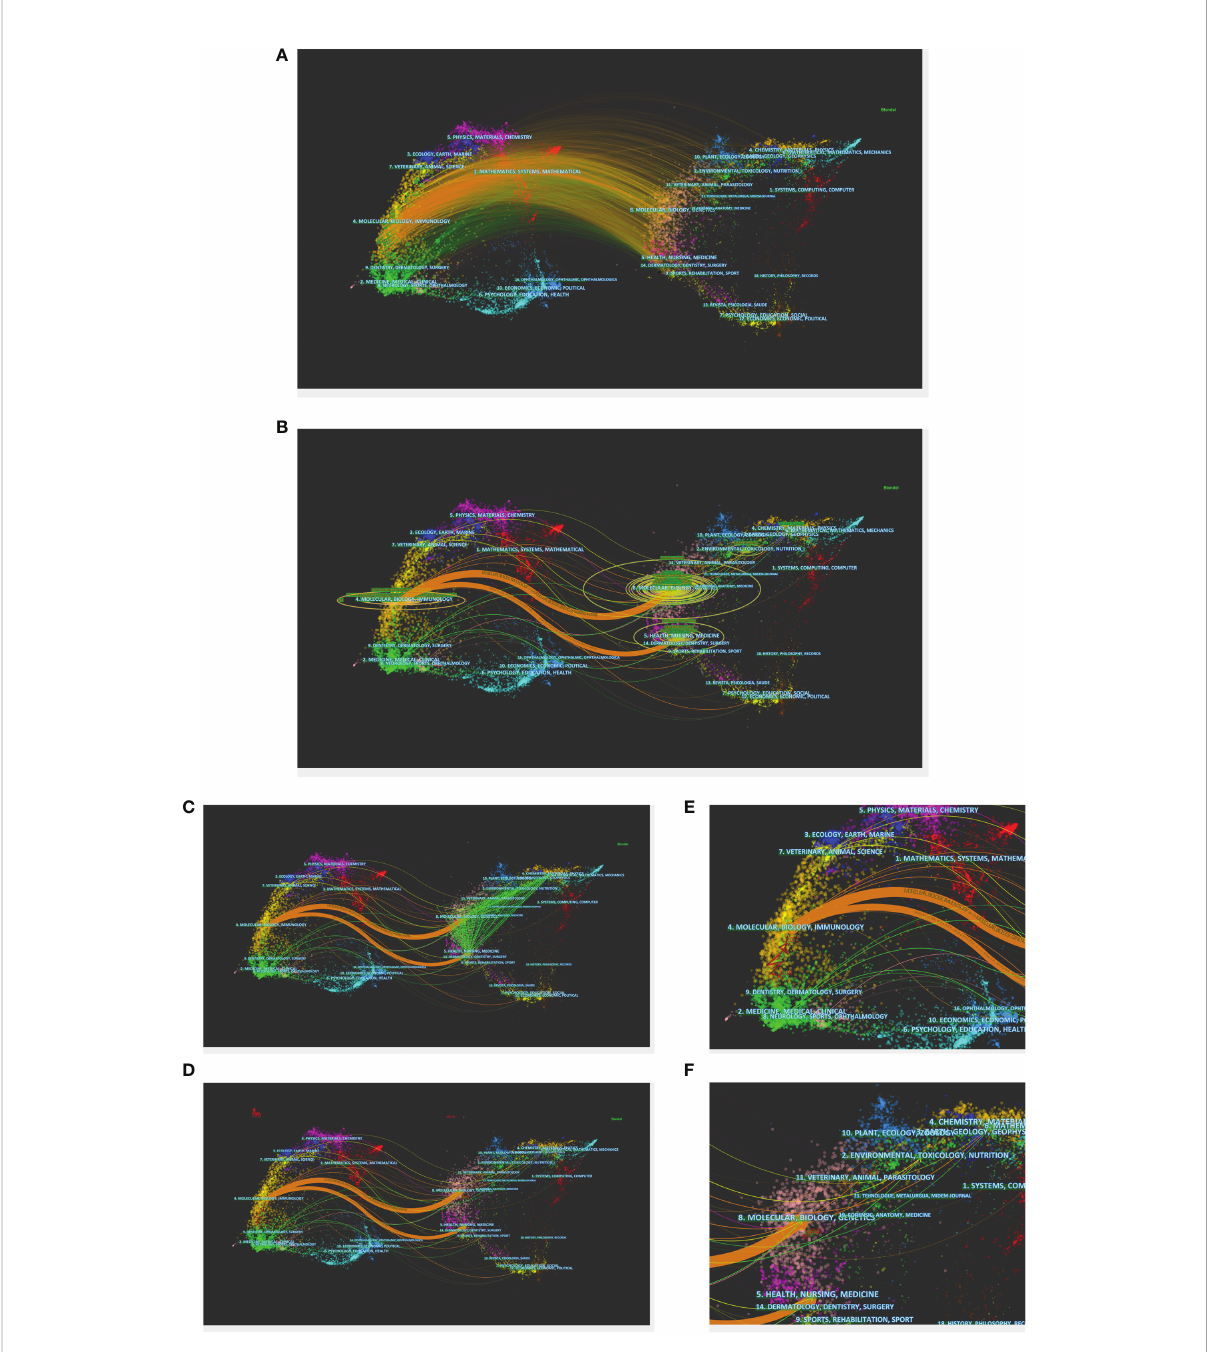
FIGURE 5 The dual-map overlay and corresponding disciplines. (A) The dual-map overlay of citing and cited article. Labels indicate corresponding disciplines of citing or cited articles. (B) The dual-map overlay using z-score function. (C) The co-citation links of the cited journals. (D) The citing and cited trajectory from 2010 to 2021. (E, F) The partial enlargement of the